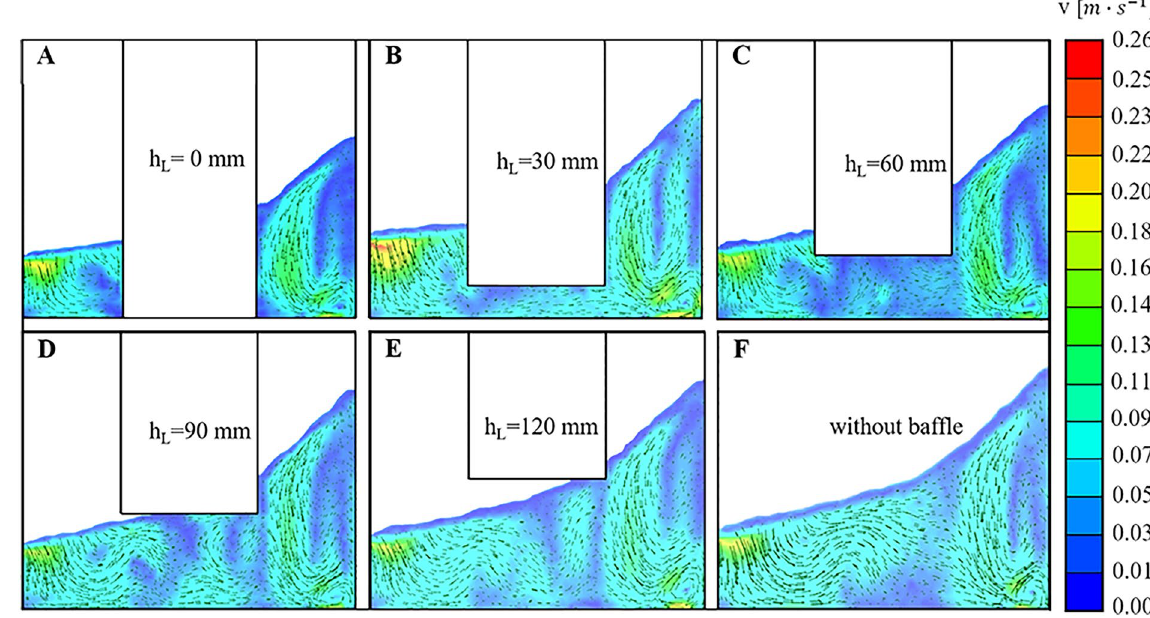
Figure 5. The fluid velocity distribution on vertical section of hollow cylinder OSRs with different installation heights. The position of the vertical section was a plane of symmetry of the hollow cylinder. The color bar on the right showed the magnitude of the fluid